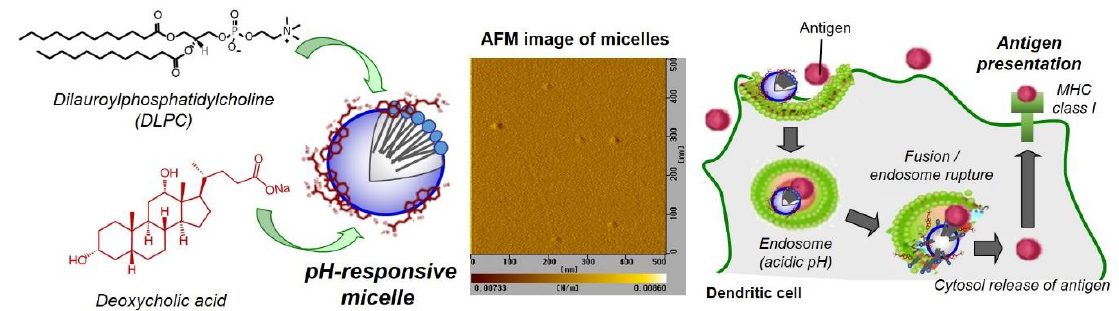
Figure 1. Design of pH-responsive micelles composed of DLPC and deoxycholic acid for antigen delivery into cytosol of dendritic cells and induction of antigen presentation via MHC class I molecules (cross-presentation), which leads to antigen-specific cellular immunity. An atomic force microscope (AFM) image for DLPC/deoyxcholic acid micelles is also